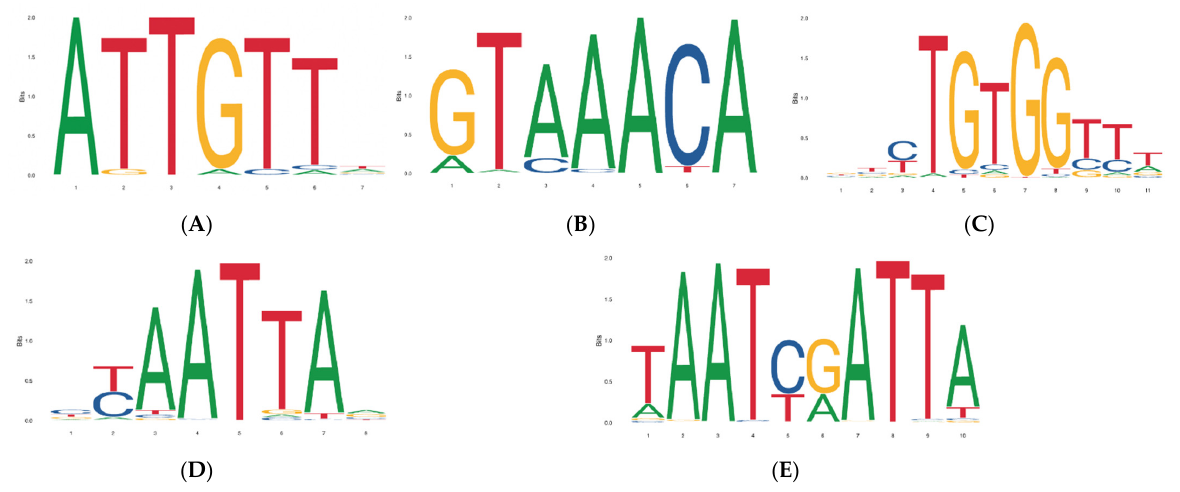
Figure 8. Transcription factor binding prediction of CNVs within the Fec B gene: ( A ) CNV1, ( B ) CNV2, ( C ) CNV3, ( D ) CNV4, and ( E ) CNV5. Note: this figure represents the distribution of bases on each